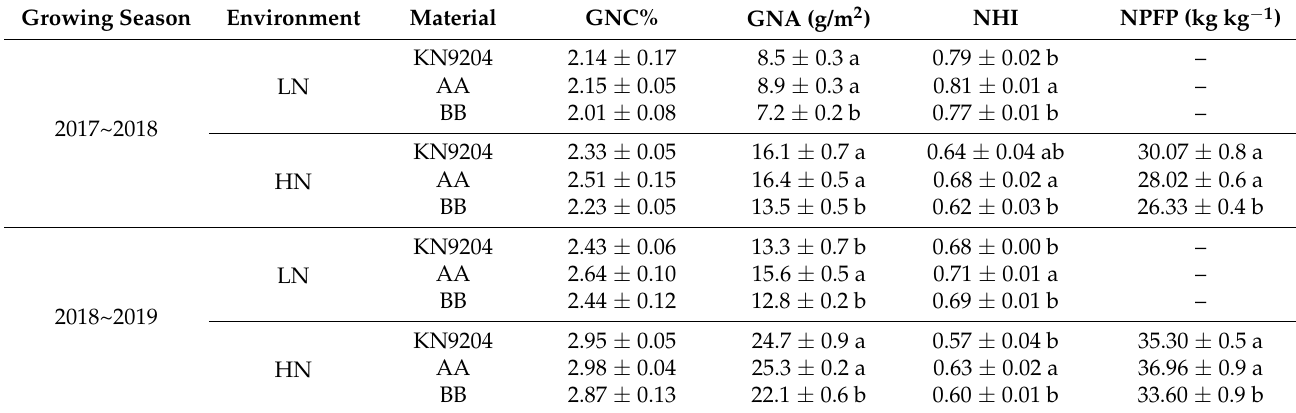
Figure 4. Aerial N content (ANC) ( A – D ) and accumulation (ANA) ( E – H ) of KN9204 and the QMrl - 7B near isogenic lines (NILs) at different stages. 2017~2018 and 2018~2019 indicate growing seasons; LN and HN indicate low nitrogen and high nitrogen environments, respectively; AA indicates QMrl - 7B NILs with the superior alleles; BB indicates QMrl - 7B NILs with the inferior alleles. SS, JS, PA10 and MS indicate seedling stage, jointing stage, 10 days post anthesis and maturity, respectively; different lowercases indicate significant differences ( p < 0.05) among the genotypes at the same growth stage. Table 4. GNA, NHI and NPFP of KN9204 and the QMrl - 7B